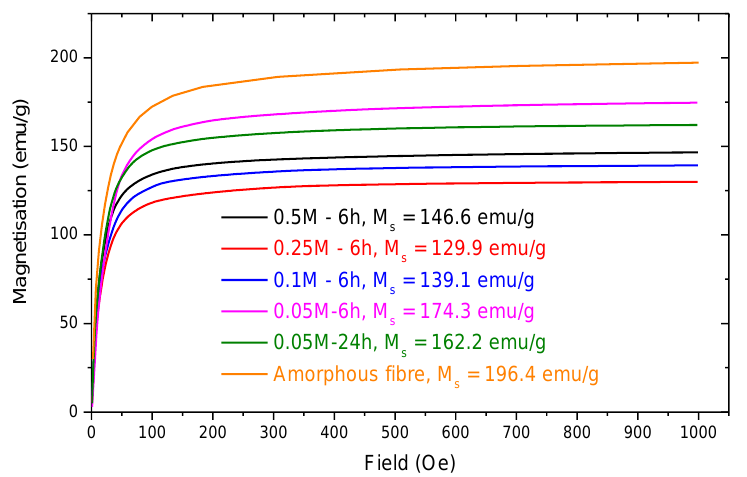
Figure 13. VSM measurements of fibres coated with ZnO using different-concentration precursors and different deposition duration.